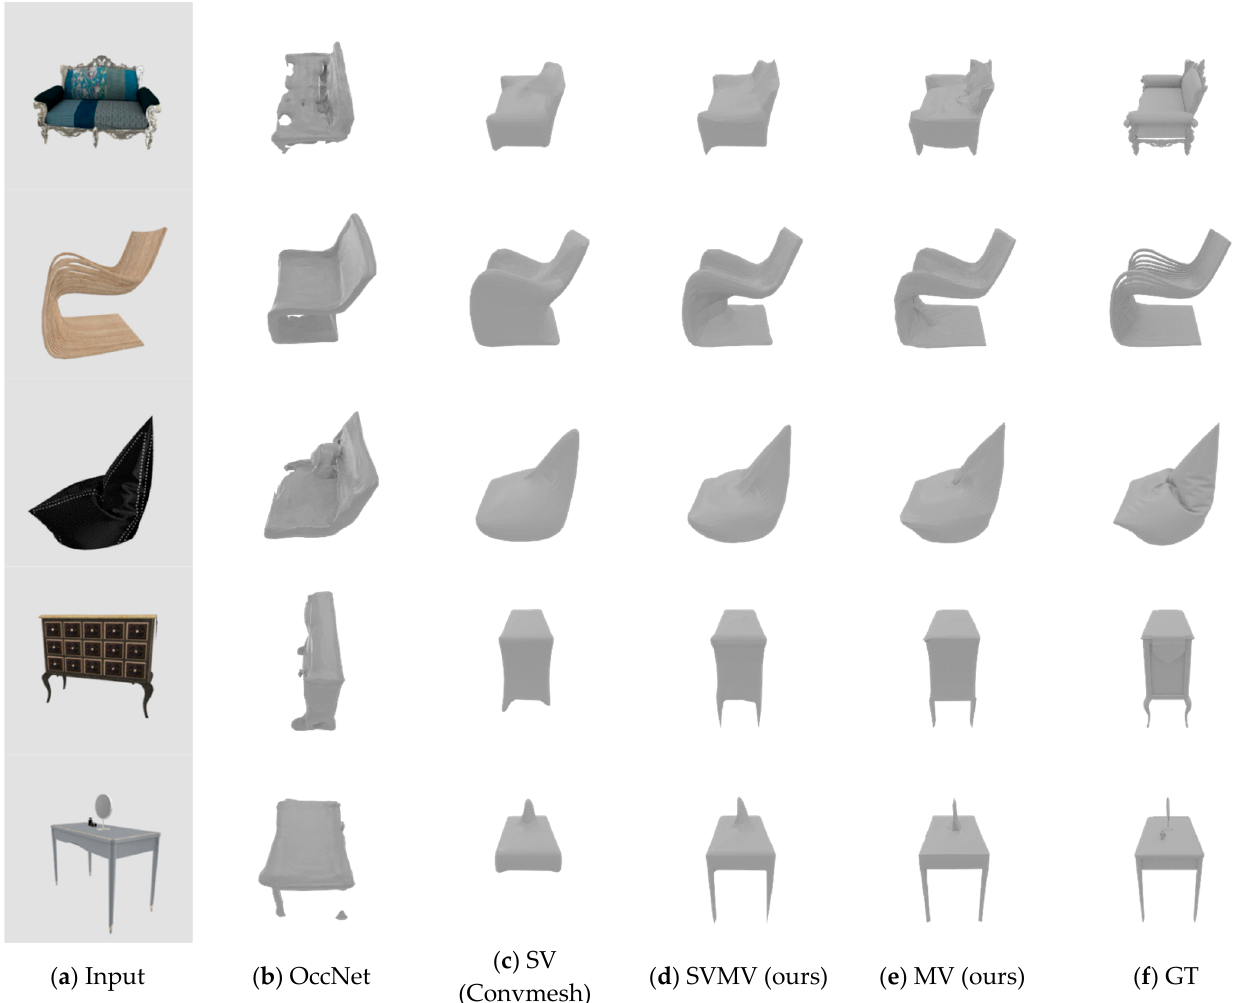
Figure 4. Mesh reconstruction results. Given the input ( a ) image, we compare the mesh generation results with those of our model trained using single view supervision ( d ) and multi-view supervision ( e ) to the results obtained using ( b ) OccNet and ( c ) SV(Convmesh). The ground truth mesh is shown in ( f ). All the mesh images were rendered using Blender.